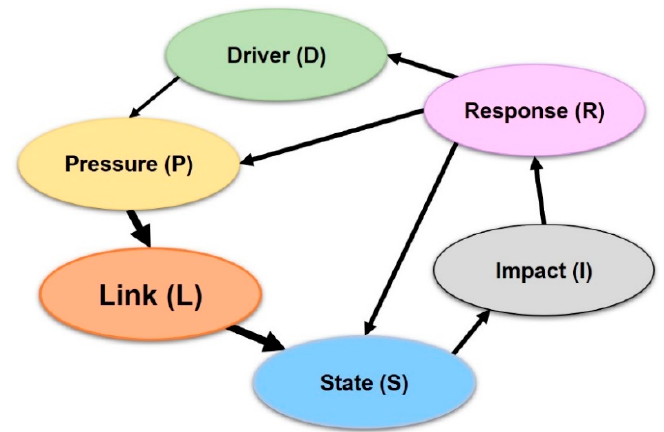
Figure 1. DPLSIR framework proposed in this study, including driving forces (D); pressures (P) on the environment; the link (L) between pressure and state; the state (S) of environmental changes; impacts (I) on ecosystems, human health, and society; and a societal response (R).